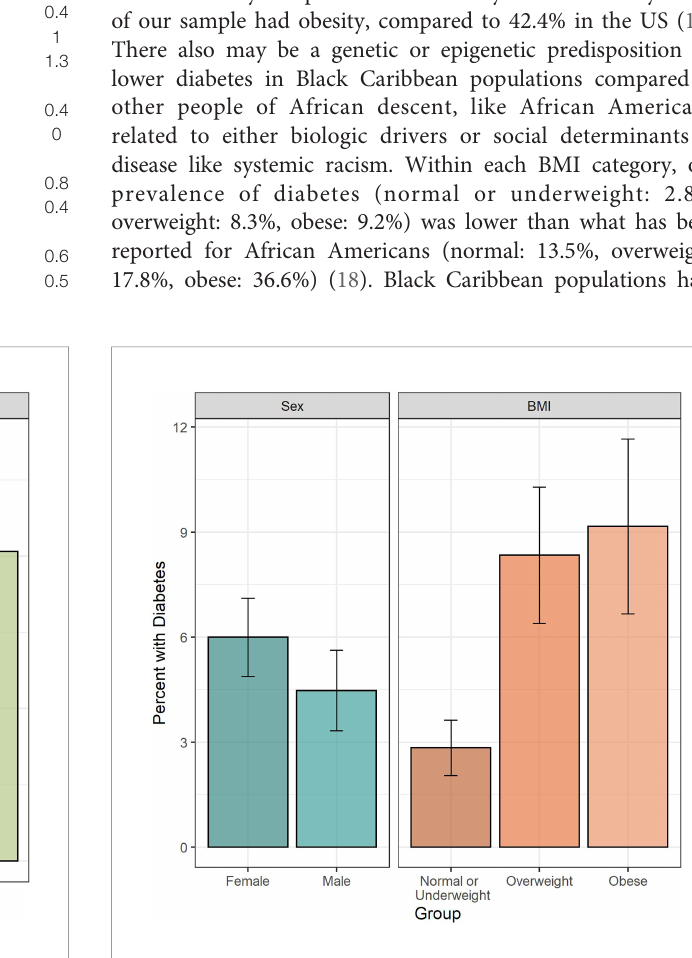
FIGURE 2 | Diabetes prevalence by sex and BMI. Legend: Bar height indicates estimated diabetes prevalence, with 95% CI indicated by whiskers. Left panel shows diabetes prevalence by sex, right panel shows diabetes prevalence by BMI category.